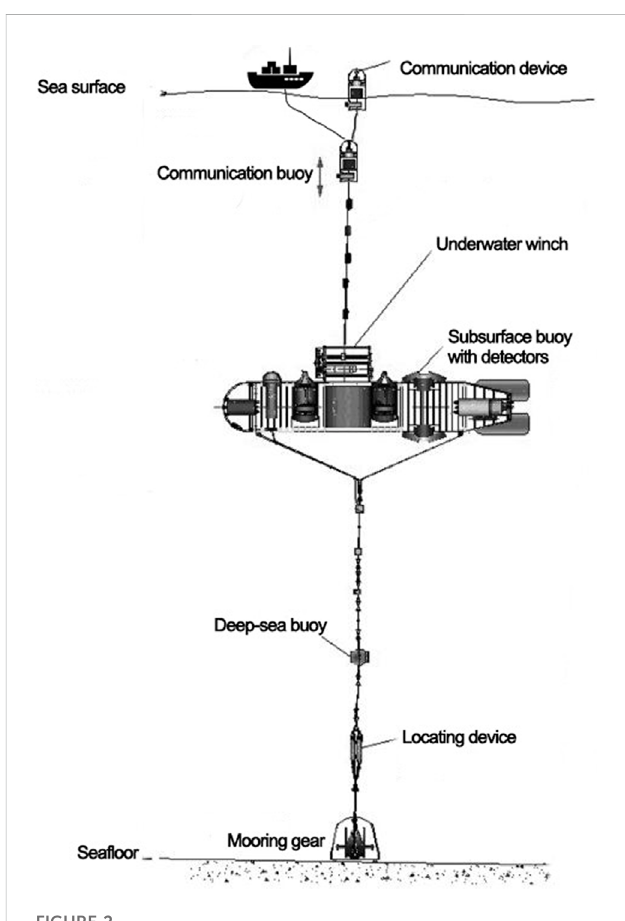
FIGURE 2 Schematic diagram of subsurface buoy with sensors (Xu,